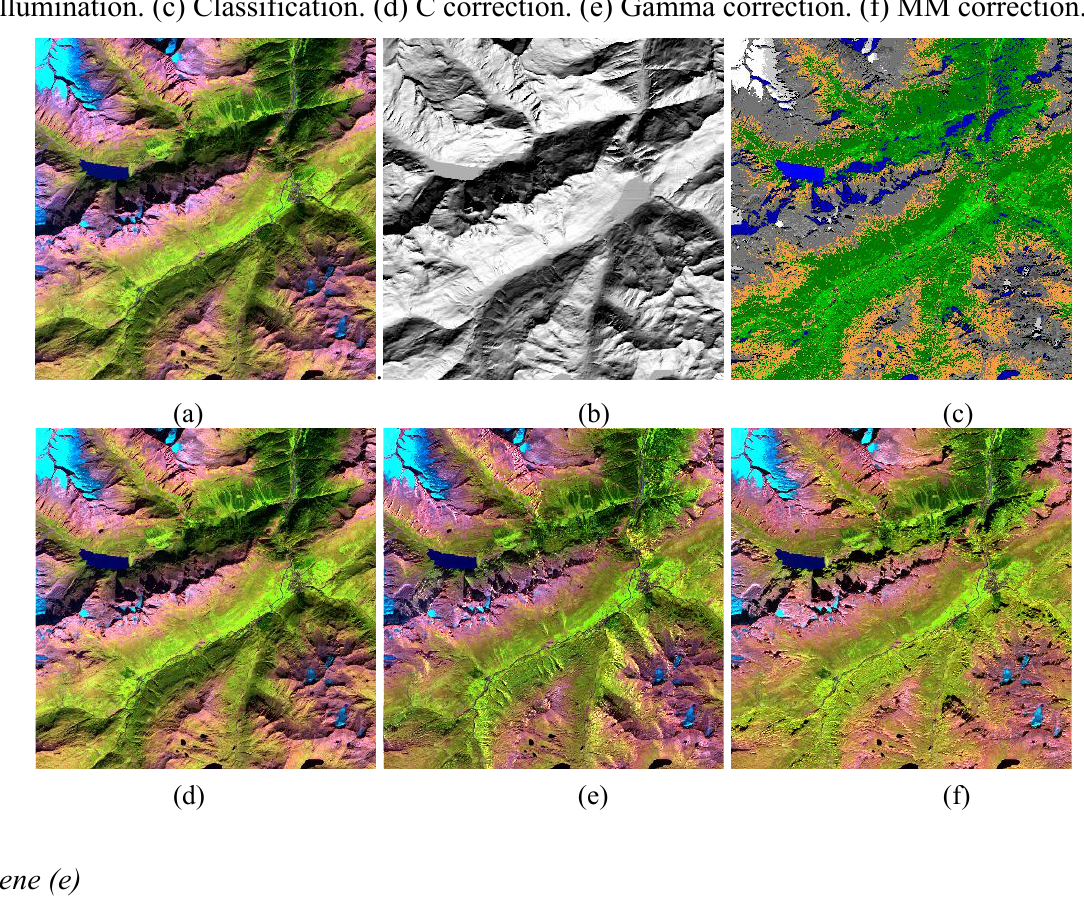
Figure 4. Sub-scene of (d), RGB = bands 4, 3, 2 (1650, 840, 660 nm). (a) Original.